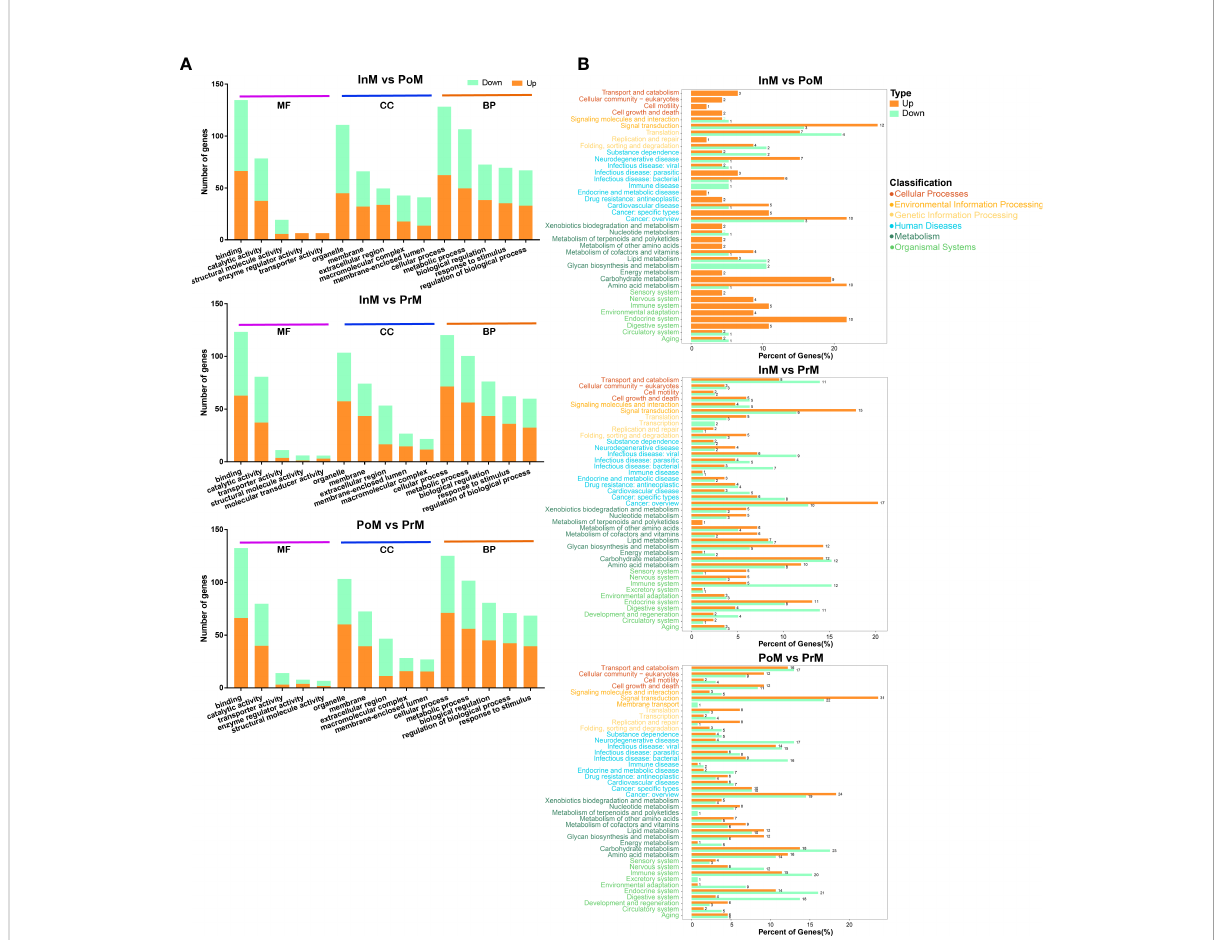
FIGURE 4 Enrichment of DEGs between the molting stages in GO and KEGG annotation. (A) Enriched GO terms of DEGs between the molting stages. MF, Molecular Function; CC, cellular component; BP, biological process. (B) KEGG enrichment analysis of DEGs between the molting stages. PoM, postmolt; InM, intermolt; PrM,